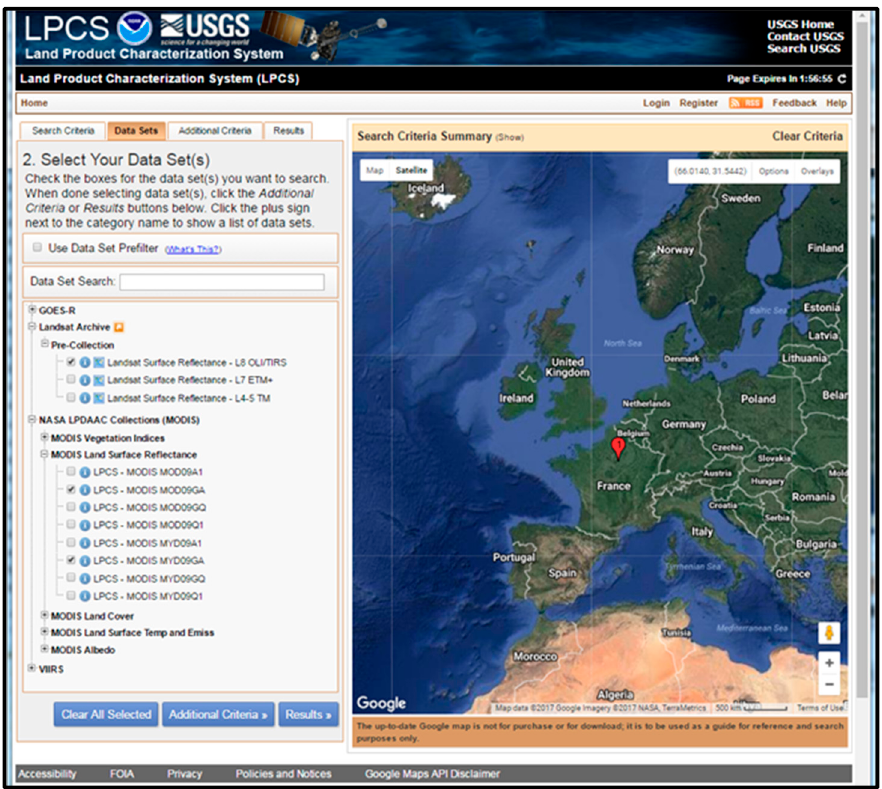
Figure 3. Screenshot of the Data Set selection page and current options. Table 1. Current data sets included in the LPCS and available dates of data. LPCS Data Sets with Full Processing Available Available Dates of Data